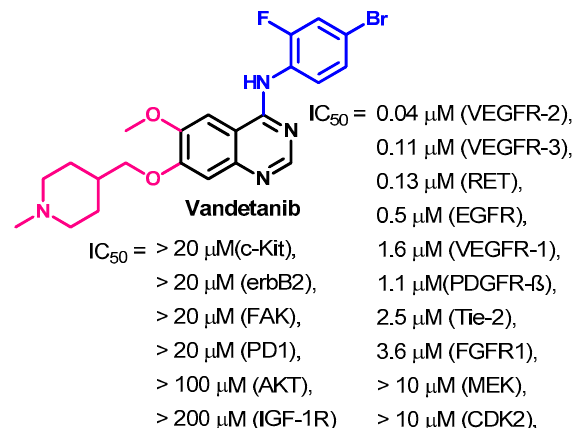
Figure 63. Kinase inhibitory activity of vandetanib.